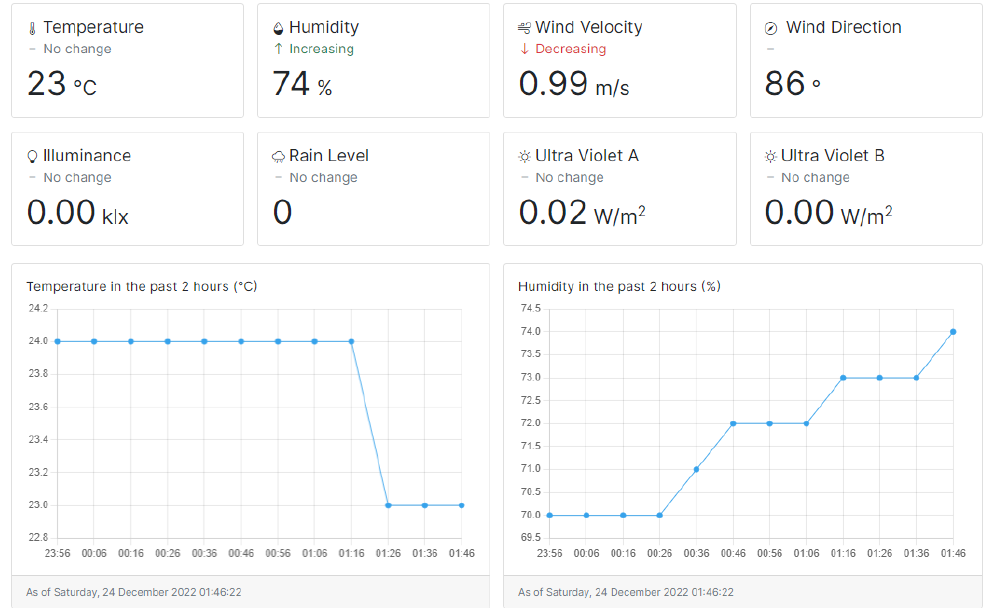
Figure 2. The dashboard shows on the user interface on the web application